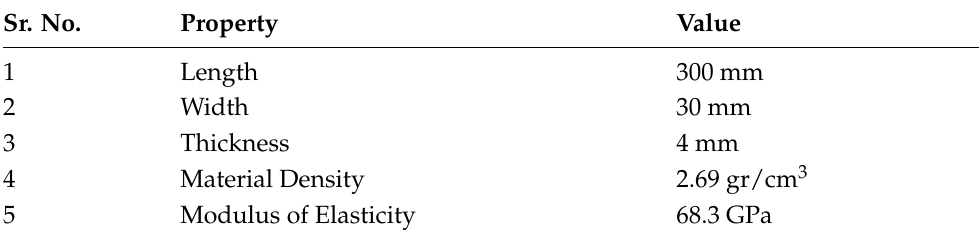
Table 3. Physical and geometrical properties of the 6063 aluminum alloy rotating blades Sr.